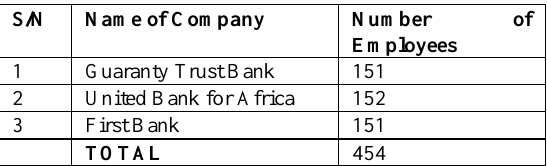
Table 2: The Sample Allocated to Each Selected